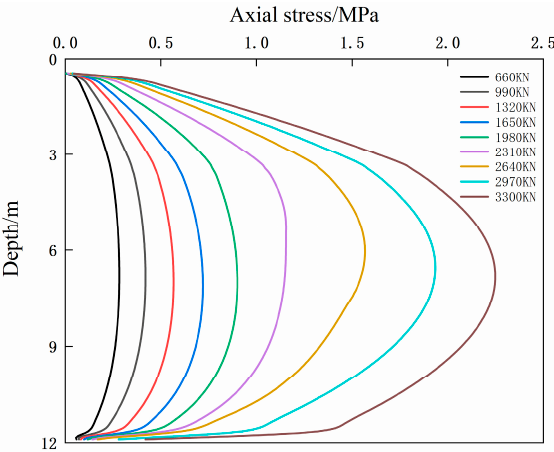
Figure 8. Simulation results of axial stress of cemented soil.